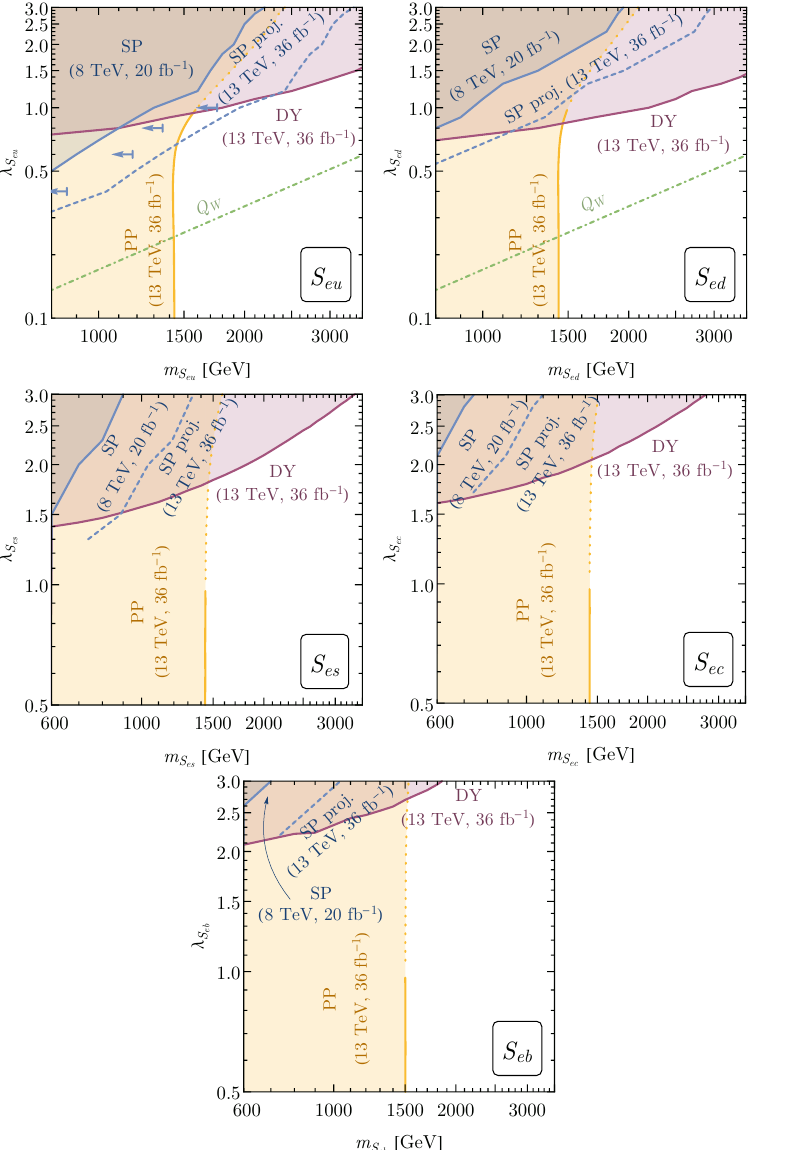
Figure 8. 95% CL limits on the parameter space for scalar MLQ S eq ( q = u; d; s; c; b ). The pair- production (PP) limits are recast from [12]. The single-production (SP) limits are recast from a Run 1 search [17] with our projections for the Run 2 reach, and DY limits are based on [13]. The green dot-dashed lines show constraints from weak charge measurements described in appendix